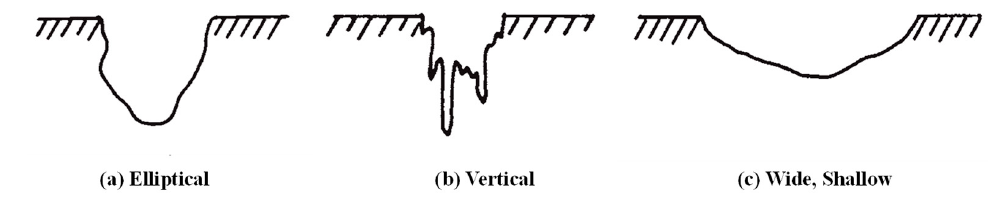
Figure 7. Variations in the cross-sectional shape of pits mentioned in ASTM G46.